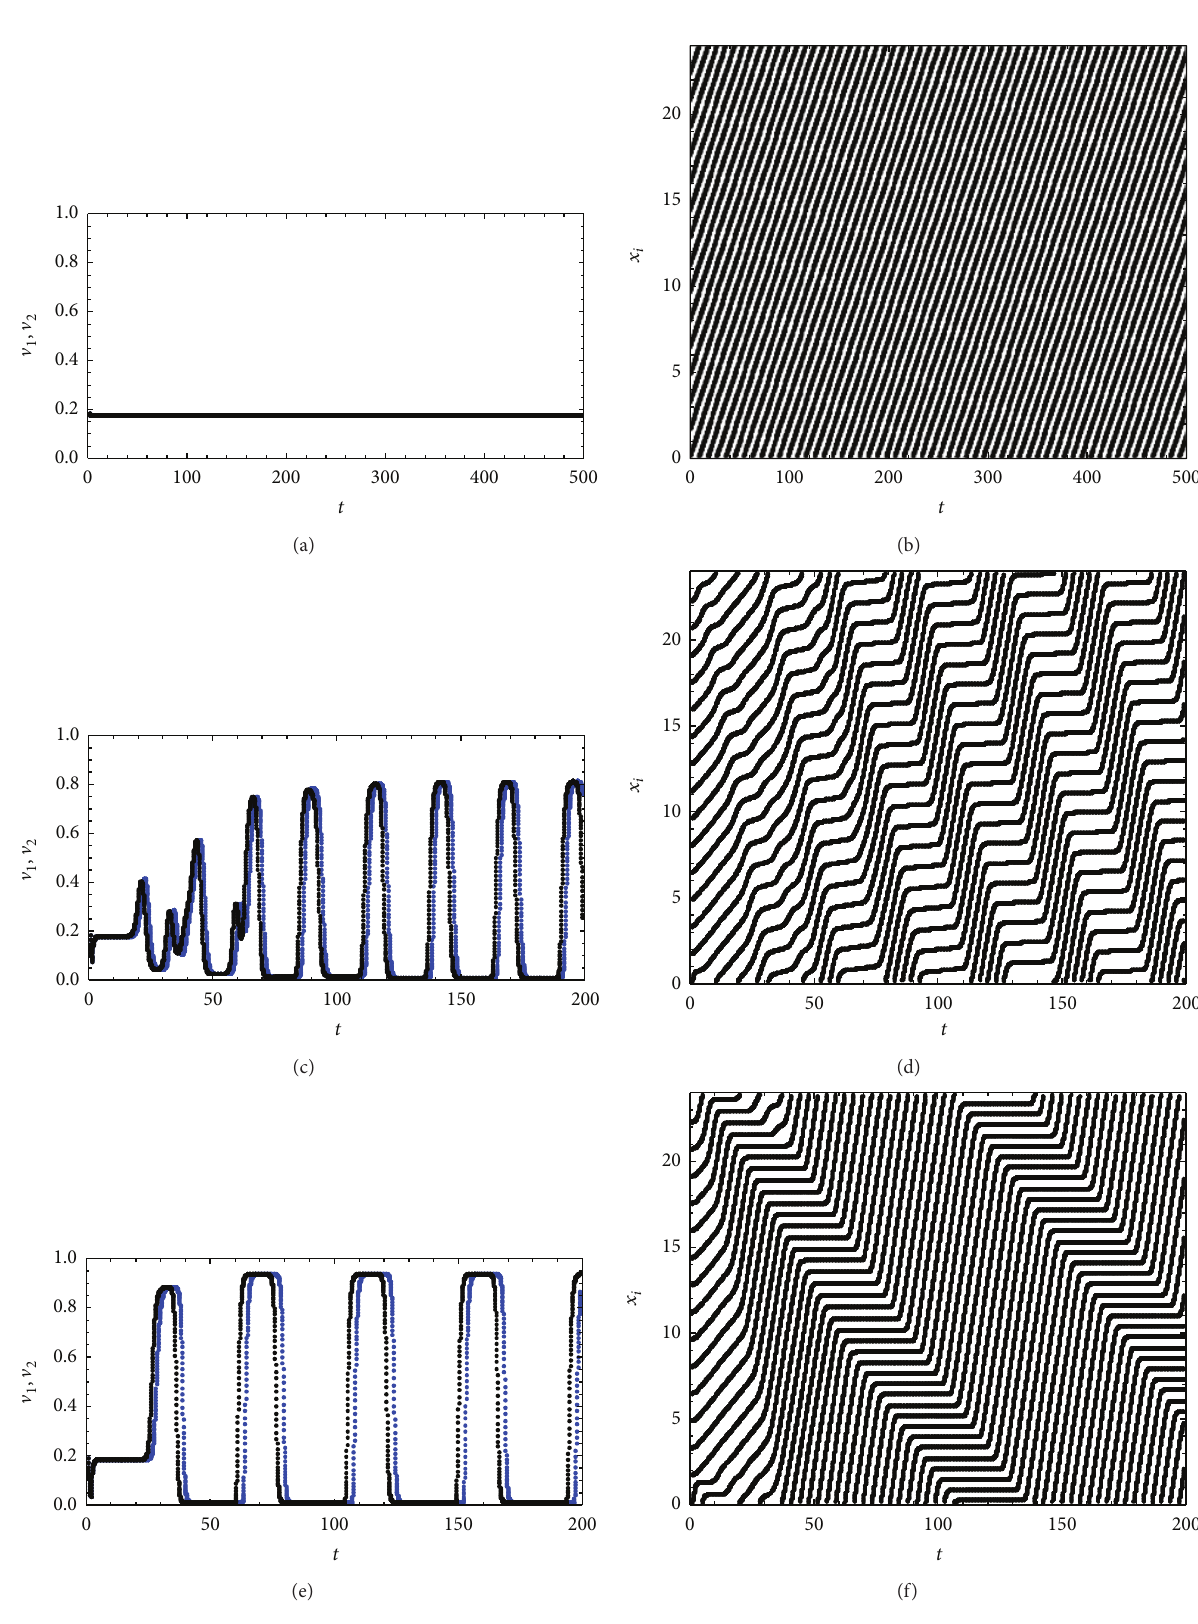
Figure 5: Plot of the velocity and the location of vehicles against time in different regions. We consider the speeds of the first two cars and the location of fifteen cars. The blue curve represents the speed of the first car and the black curve represents the speed of the second car. The initial condition is set for 𝛼 = 2 , ℎ ∗ = 1.6 , V = 0.18 . (a) and (b): 𝜏 = 0.2 . (c) and (d): 𝜏 = 0.4 . (e) and (f): 𝜏 = 1